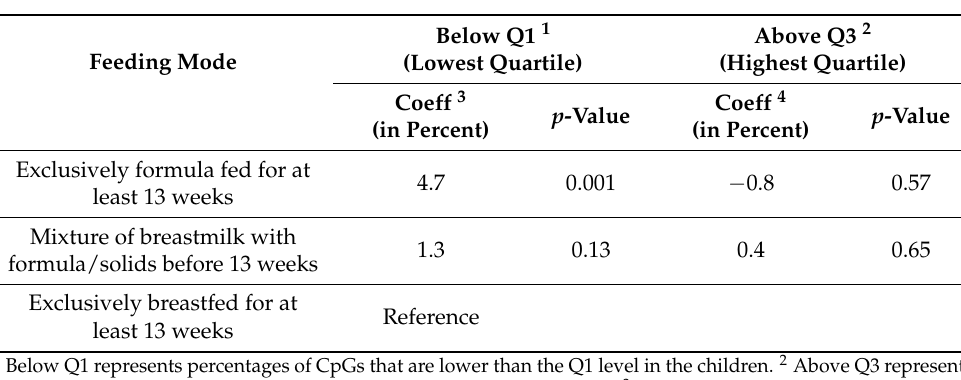
Table 4. Association of the percentages of CpGs that change between birth and age 10 years (delta- residuals) in the lower 25% (below Q1) and in the higher 25% distribution (above Q3) of the methyla- tion of single CpGs related to infant feeding